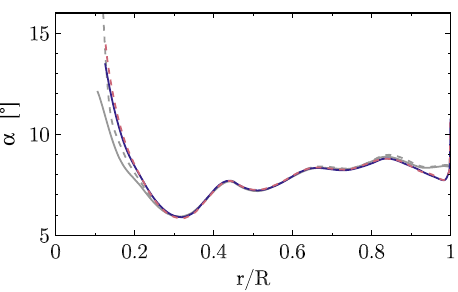
Figure 12. Radial distribution of the angle of attack for CaseIsoRotor (dashed) and CaseT1.0 (solid) using the RAV method (gray) and the line average method